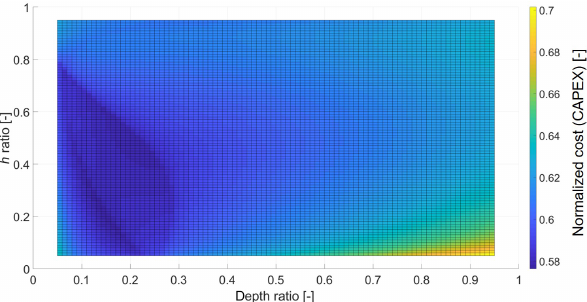
Figure 4. 2D view of the response surface. Design no. 1, normal- ized cost